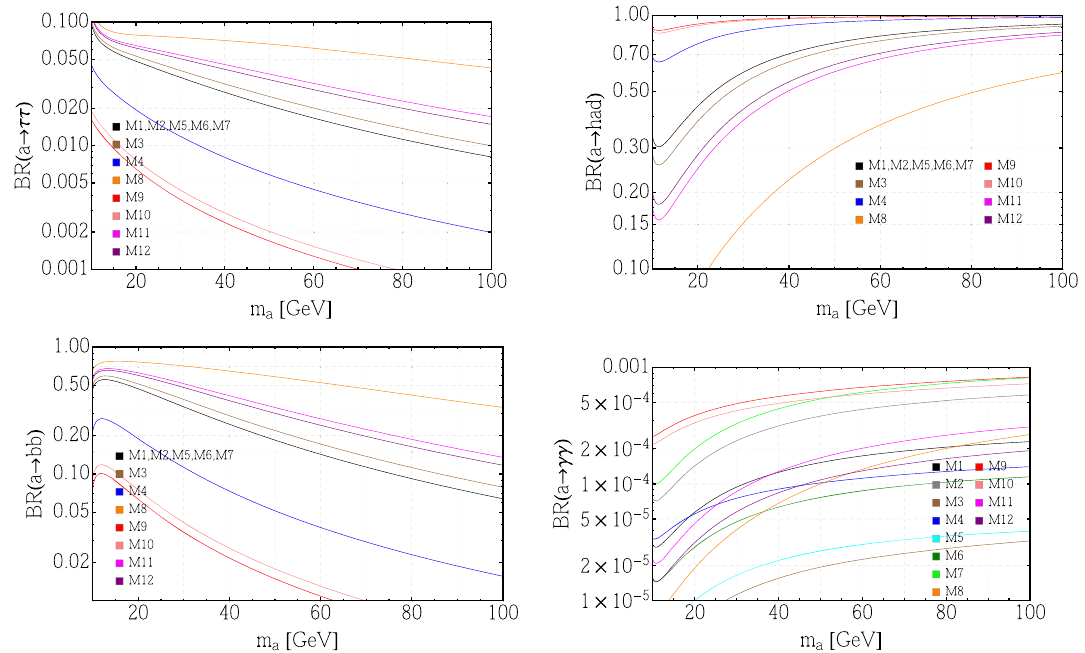
Fig. 7 Main branching ratios of the TCP for the reference models M1-M12 (c.f. Table 1) as a function of m a : a → τ + τ − (top-left), a → hadrons (top right), a → b ¯ b (bottom-left) and a → γγ